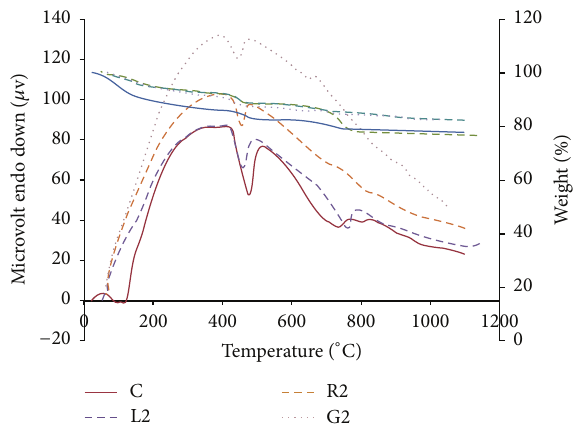
Figure 9: TG-DTA curves of C, L2, R2, and G2 at 7d.